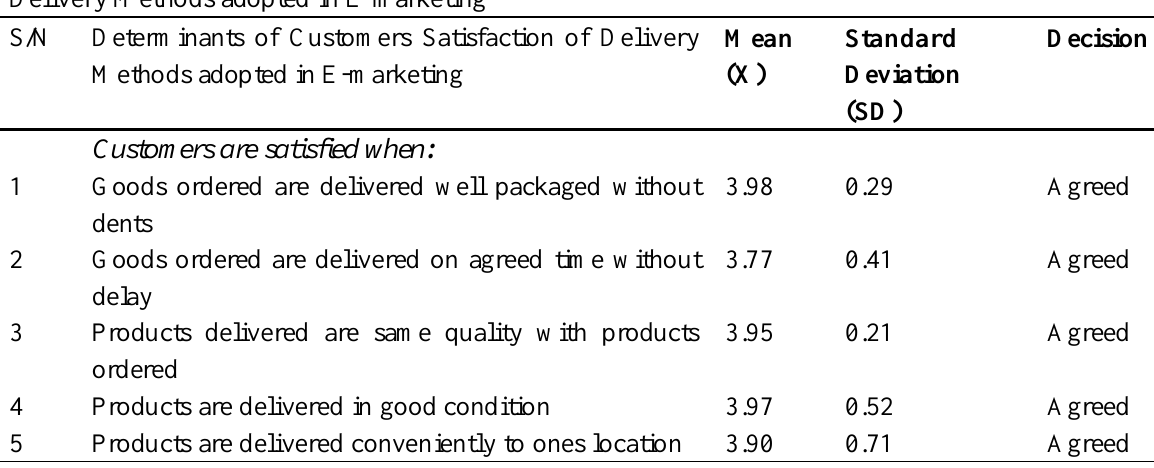
Table 3: Mean Ratings and Standard Deviation Responses on Level of Customers Satisfaction of Delivery Methods adopted in E-marketing